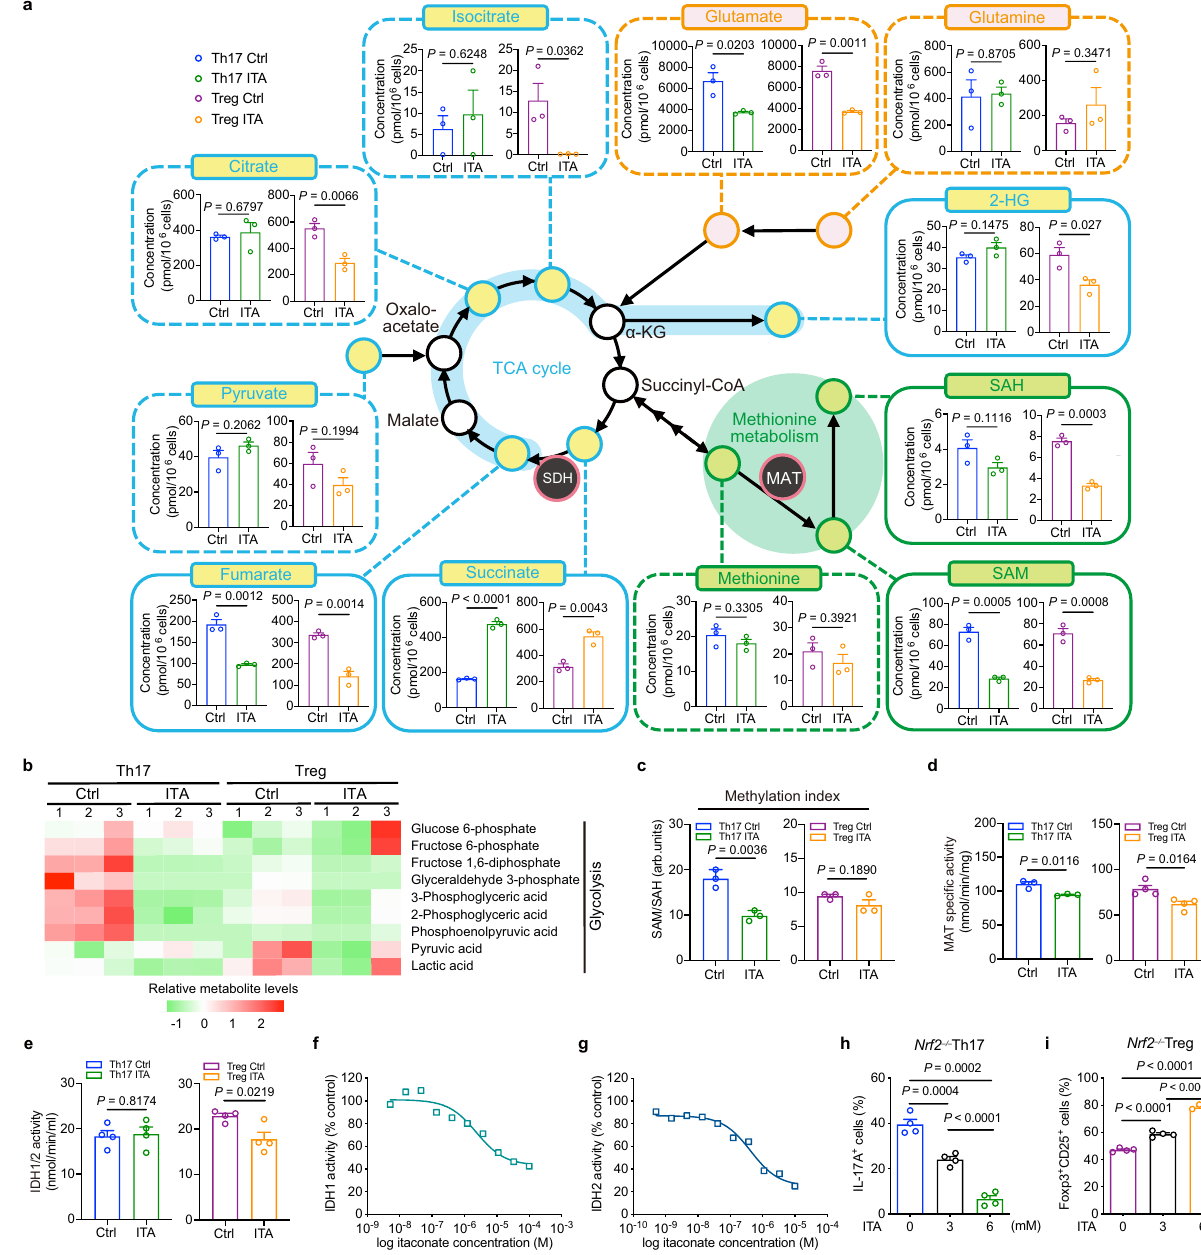
Fig. 5 | Metabolic reprogramming and enzymatic inhibition in Itaconate- treated Th17- and Treg-polarizing T cells.a Intracellular levels of metabolites implicated in TCA cycle, glutaminolysis, and methionine metabolism from Th17- and Treg-polarizing T cells in the presence or absence of itaconate (ITA) after 2 days of culture ( n =3 independent experiments). b Heatmap of glycolytic metabolites from Th17- and Treg-polarizing T cells in the presence or absence of ITA. c Methylation index (SAM/SAH ratio) of Th17- and Treg- polarizing T cells in the presence or absence of ITA ( n = 3, each condition). Enzymatic activity of methionine adenosyltransferase (MAT) ( d ) (Th17, n = 3; Treg, n = 4) and isocitrate dehydrogenase (IDH)1 and 2 ( e ) in Th17- and Treg-